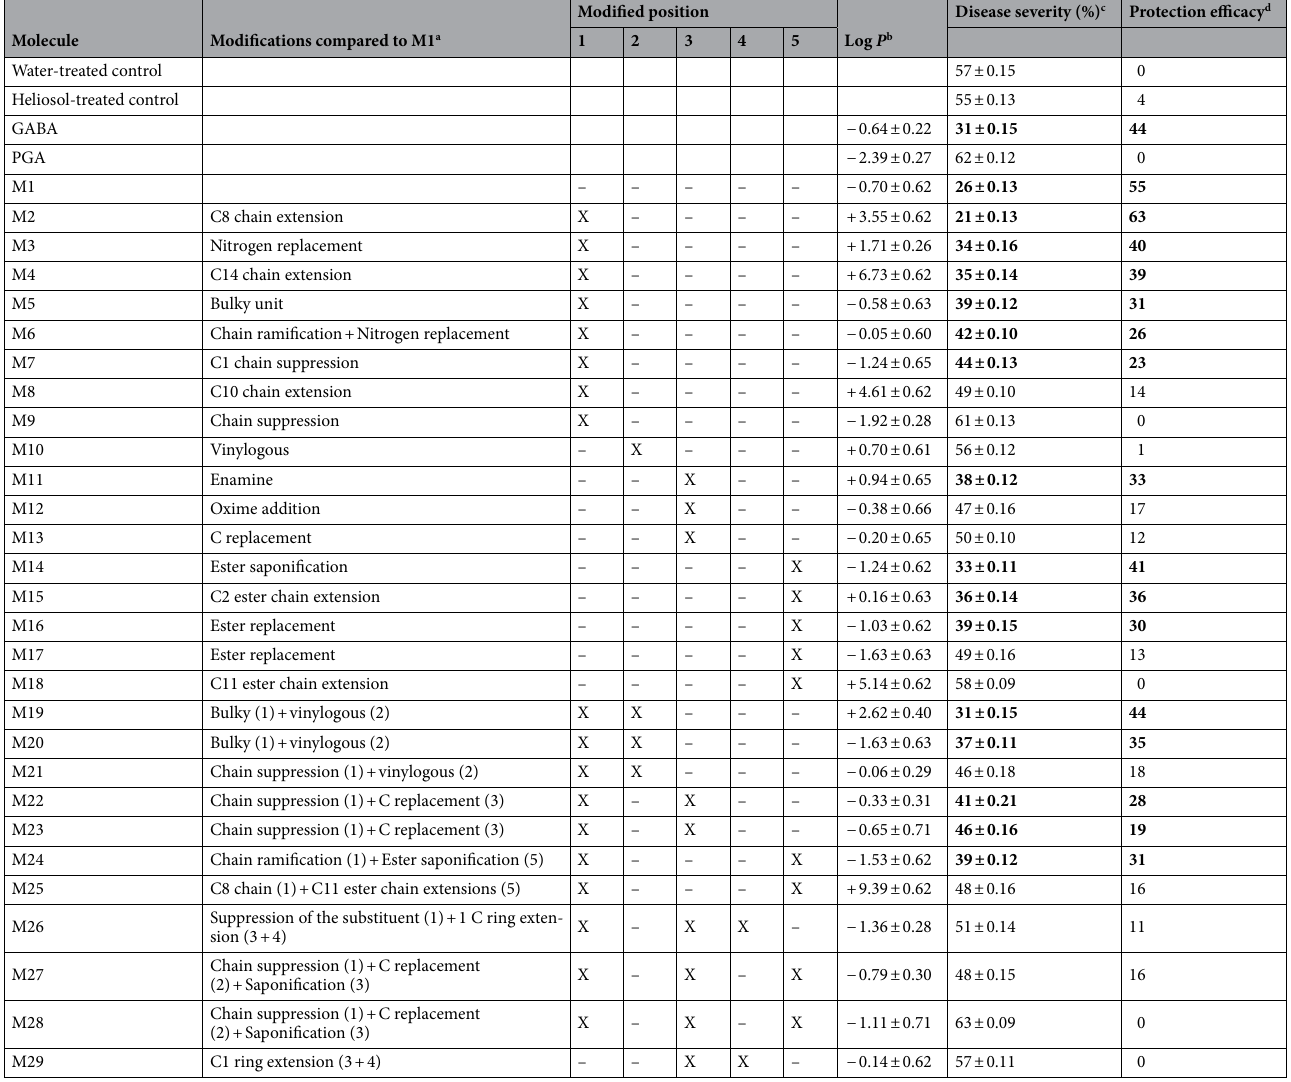
Table 1. Protection efficacy at 5 mM of γ- aminobutyric acid (GABA), pyroglutamic acid (PGA), M1 (derived from PGA) and 28 molecules functionalized from M1 on bread wheat (cultivar Alixan) against Zymoseptoria tritici (strain T02596), and description of the chemical modifications performed on M1 to obtain the functionalized molecules. a When more than one modification was performed, their positions on M1 are mentioned between brackets. b Calculated with ACD/Log P software. ± indicates standard deviation. c,d Disease severity (percentage of leaf area with lesions bearing pycnidia) and protection values highlighted in bold are significantly different from the water-treated control according to the Tukey test at P = 0.05. A total of 36 third leaves were used as replicates in each treatment and the control. ± indicates standard